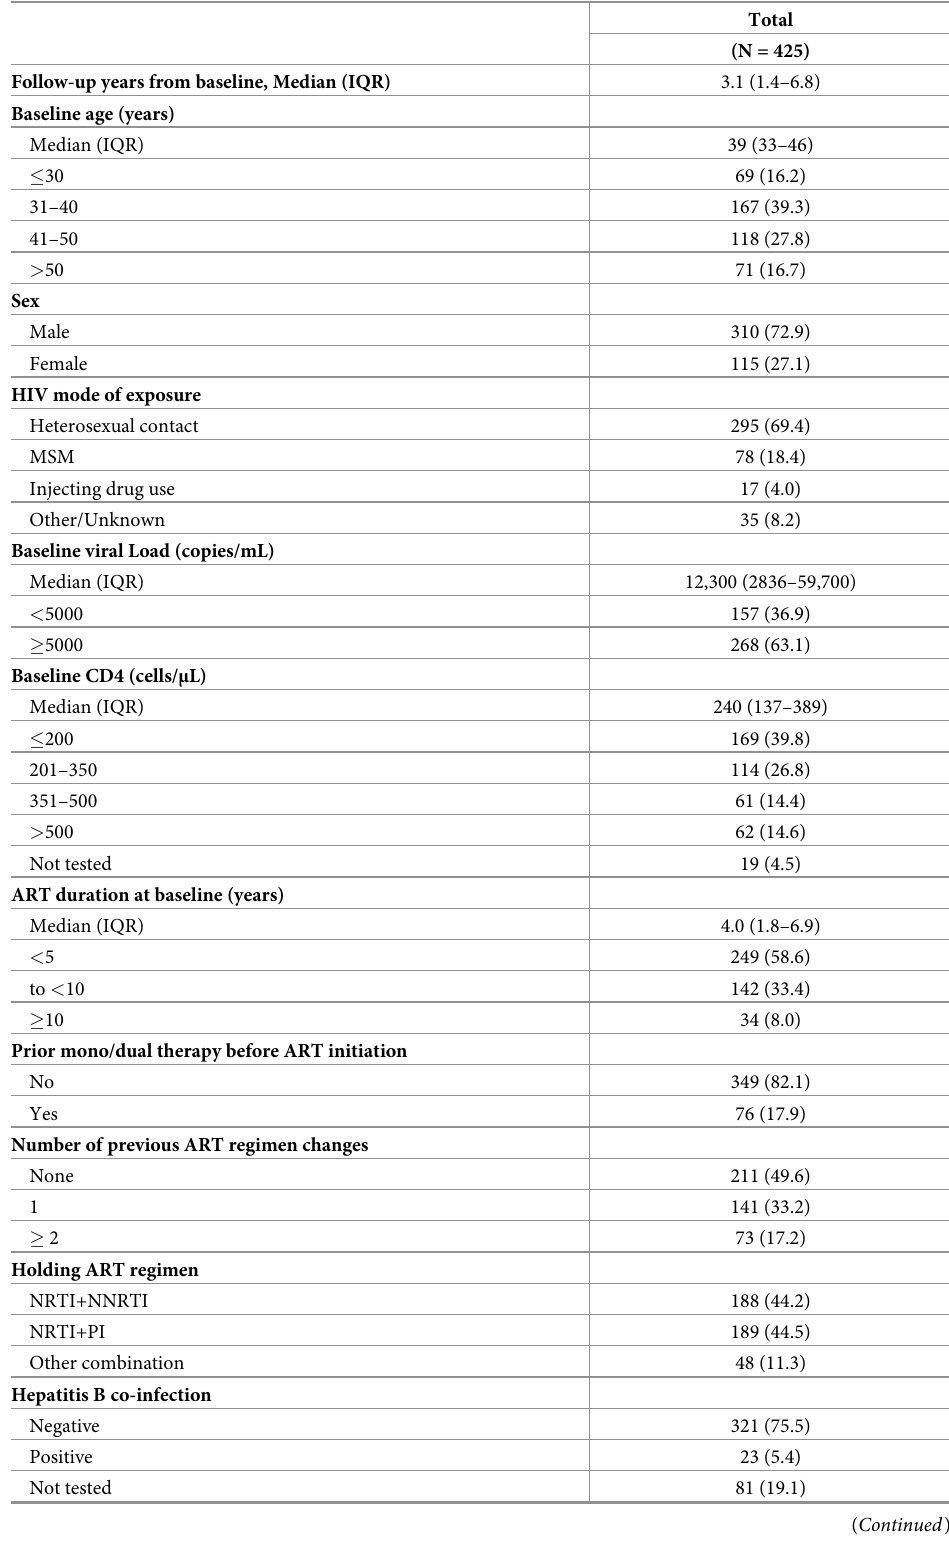
Table 1. Baseline characteristics of patients with holding